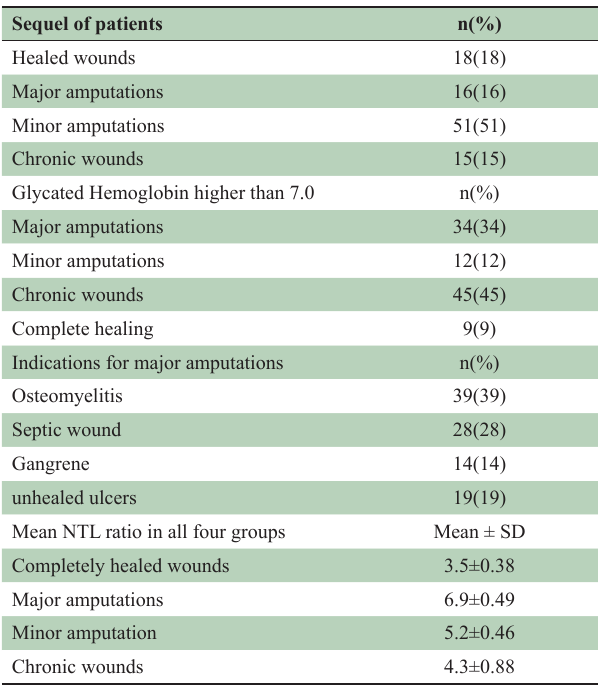
Table-II: Patient’s disease outcome and their relationship with laboratory